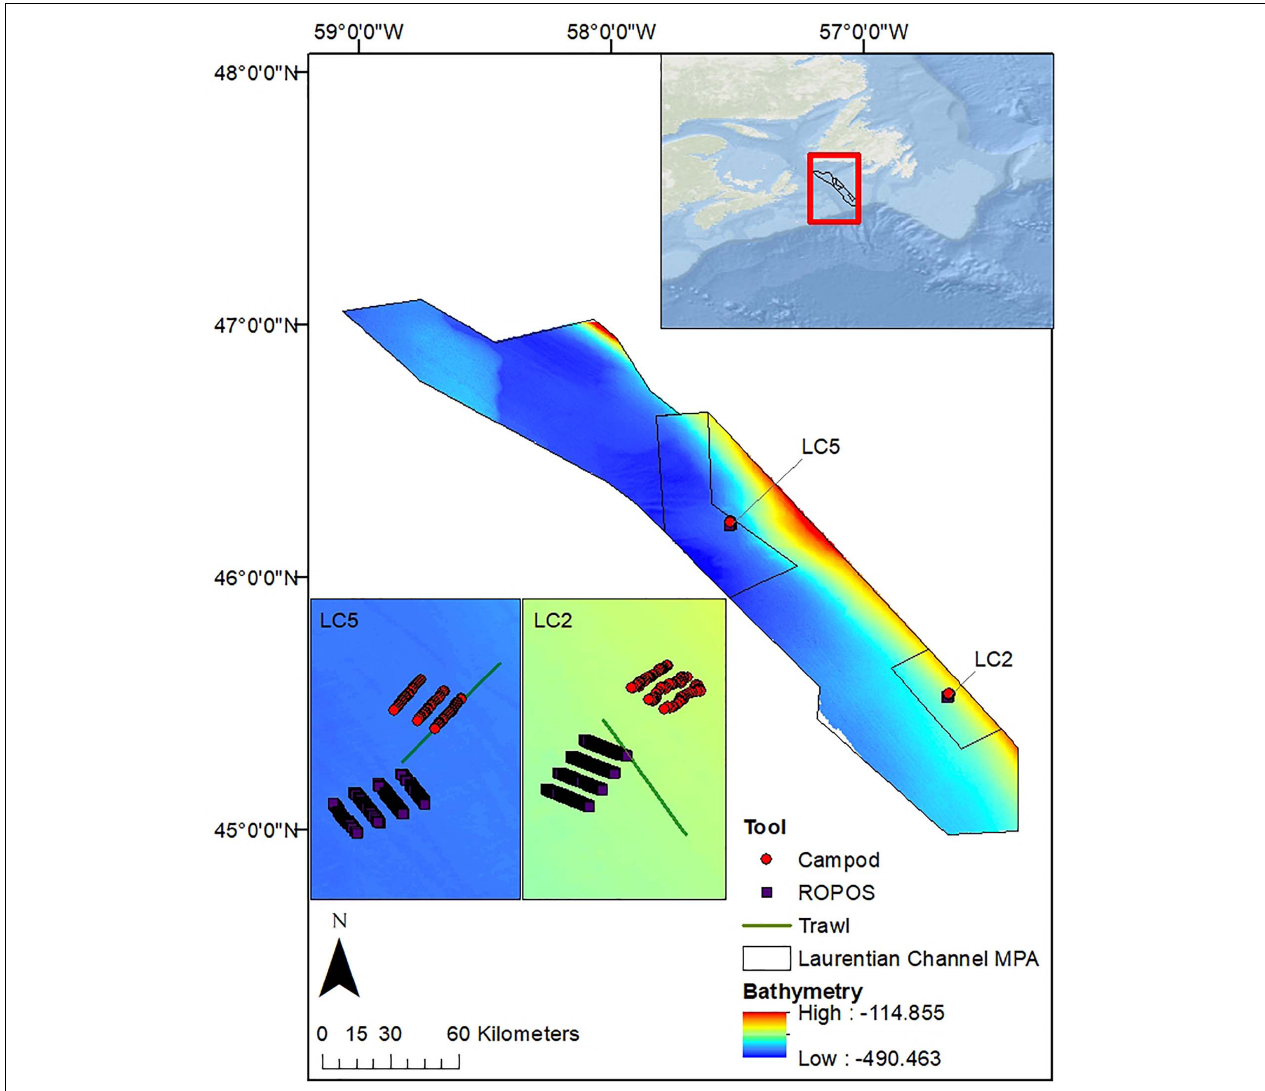
FIGURE 1 | Map of the Laurentian Channel MPA (boundary provided by DFO), in Atlantic Canada off the southwest coast of Newfoundland indicating the locations of the two sampling stations (LC2 and LC5). Shown are 8 400-m ROPOS transects, 3 400-m Campod transects, and trawl set at station LC5 (inset i) and LC2 (inset ii). Esri (2020) for World Ocean Base layer, using coordinate system GCS_WGS_1984. Bathymetry data layer (in meters) is from Lacharité et al. (2020). This MPA is located within a deep submarine valley in the Northwest Atlantic and was designated to protect corals (predominately sea pens), several fish and shark species, as well as leatherback turtles (DFO,